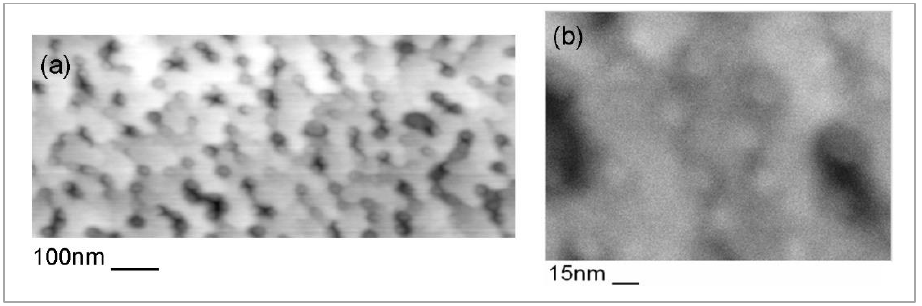
Figure 5. AFM topography ( a ) and ADF-STEM image in plan-view ( b ) of 8 nm GaAs overgrowth of In 0.25 Ga 0.75 As quantum dots, showing trench formation around them. ( a ) is a detail reproduced with permission from [34].